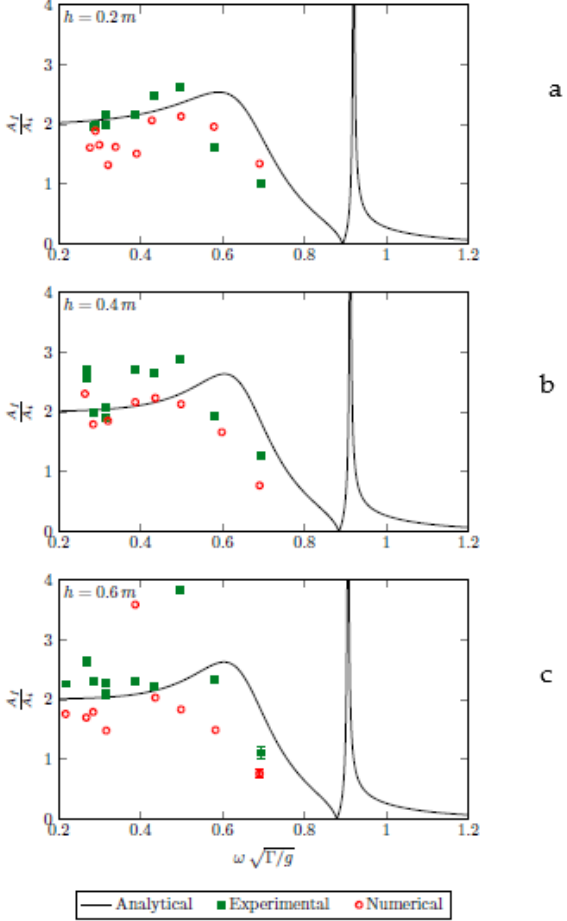
Figure 8. Floater response at different water depths for floater 1 at D = 0.01 m and different water depths: ( a ) h = 0.2 m; ( b ) h = 0.4 m; ( c ) h = 0.6 m. Model errors are represented for experimental and numerical models for one test (because identical for all